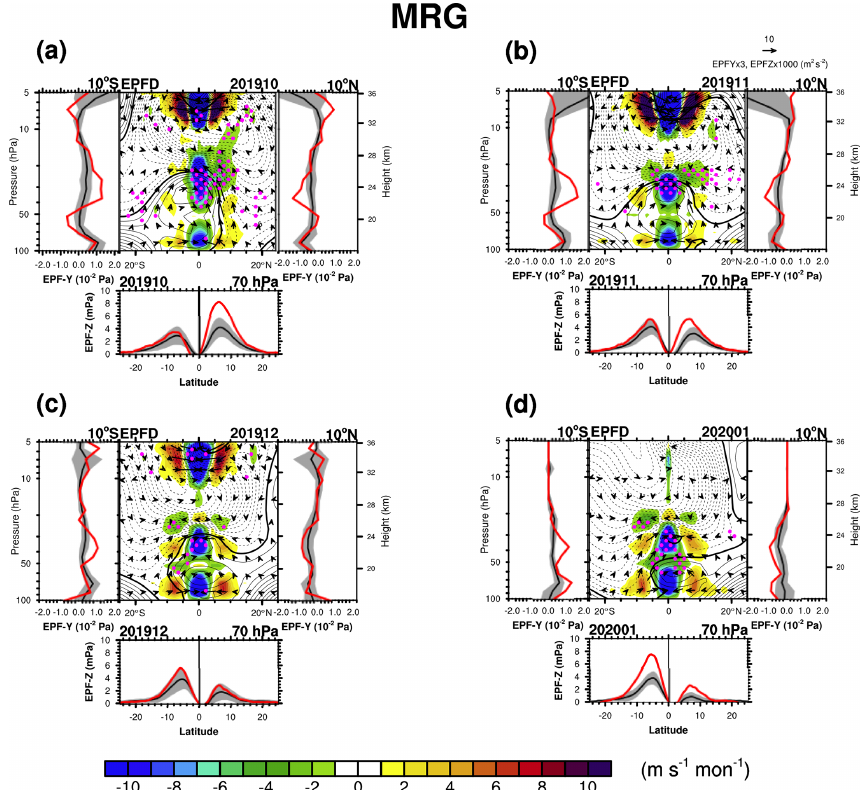
Figure 7. EPF divided by air density (vectors) and EPFD (shading) for the MRG waves multiplied by 8 and 4, respectively, in a latitude–height cross section in (a) October 2019, (b) November 2019, (c) December 2019, and (d) January 2020. The vertical profiles of the meridional EP fluxes at 10 ◦ S (10 ◦ N) are presented on the left and right sides of the EPFD, and the meridional distribution of the vertical EP flux at 70hPa is presented at the bottom of the EPFD. Contours and the magenta stipples are defined the same as those in Fig.